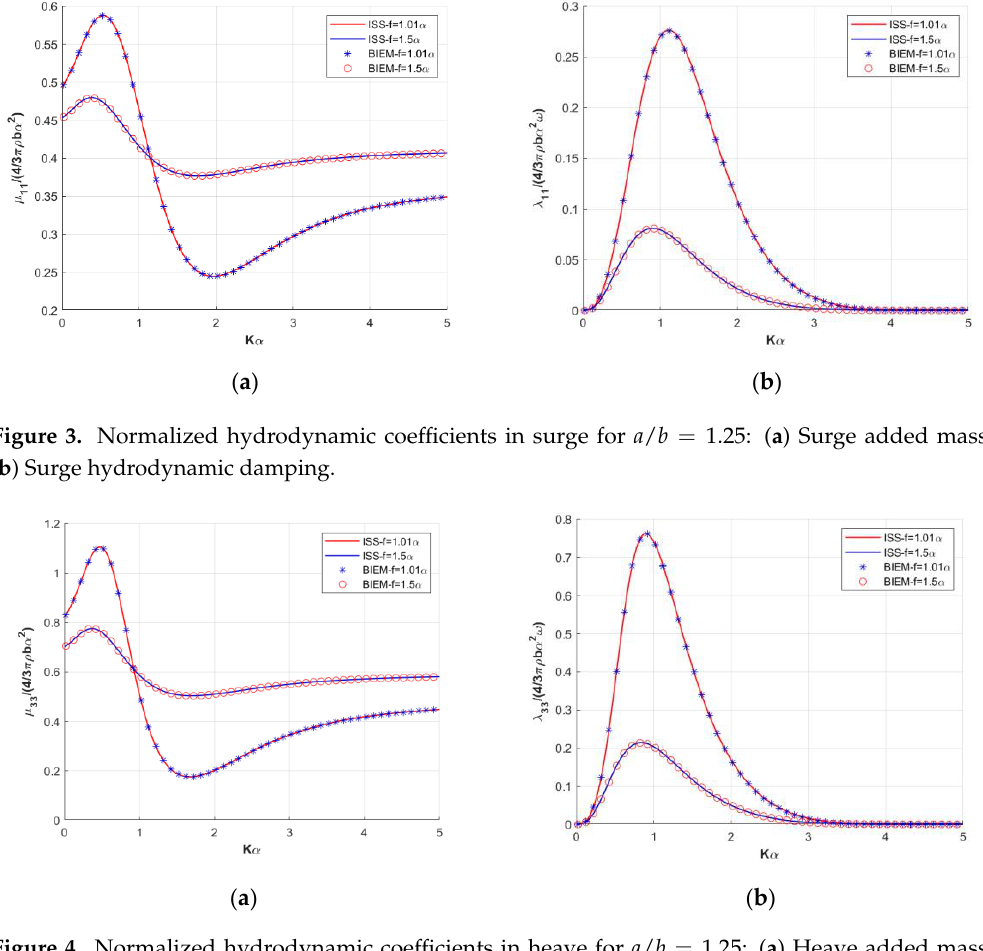
Figure 4. Normalized hydrodynamic coefficients in heave for 𝑎/𝑏 = 1.25 : ( a ) Heave added mass; ( b ) Heave hydrodynamic damping. Table 1. Convergence sequence of the normalized surge added mass and damping coefficients for several mode numbers (Oblate spheroid with 𝑎/𝑏 = 1.25 and immersion 𝑓 = 1.5𝑎 ).